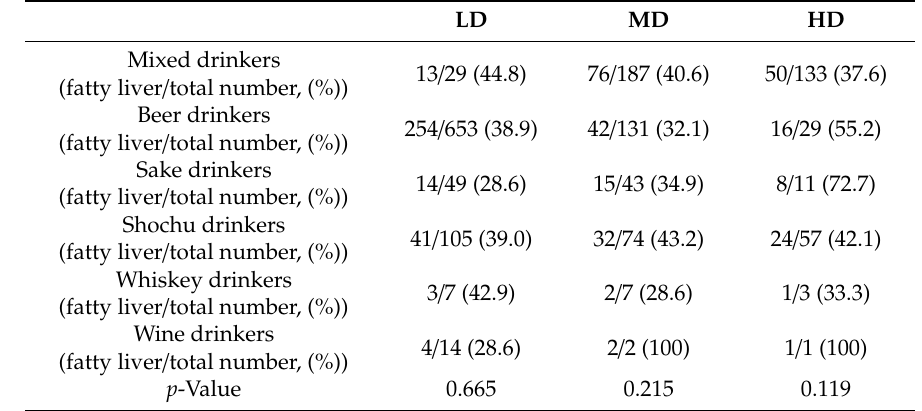
Table 5. Prevalence of fatty liver in various types of